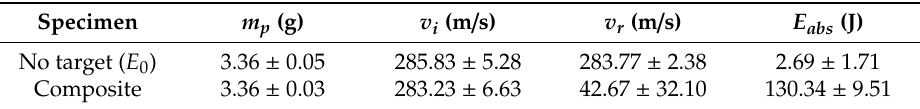
Table 1. Absorption energy test.